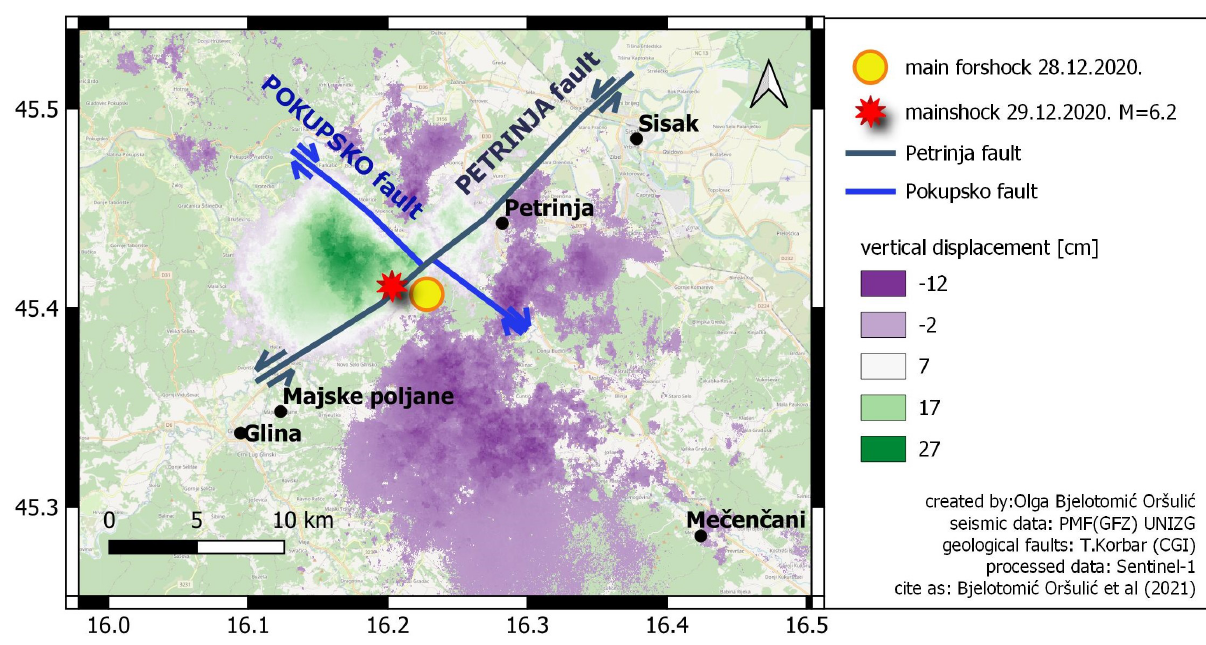
Figure 9. Figure shows vertical displacement over affected area. The results of analyzed GNSS data show that there has been a significant shift of SISA station of 5 cm towards the East and 2 cm to the South (see Figure 10). The eastern shift coincides with the results we obtained from the SAR analysis, while the north–south direction is not straightforward in SAR processing since SAR technique is more sensitive to horizontal east–west shift neglecting the north–south shift since the orbit path stretches along the north–south direction. As for the height, the SISA station shows subsidence up to 3 cm, as seen in Figure 11, which is the complementary result obtained by the SAR analysis: The identical displacement is obtained at the location of SISA station when vertical displacement is derived from SAR analysis, shown in Figure 9. Considering the geological field data acquired after the earthquake, a hundred sinkholes [76] opened as one of the extreme post-seismic near-surface effects [54] in a small place Meˇcenˇcani, located on a south-east line of Pokupsko strike-slip faults, as shown in Figure 9. Comparing the vertical displacements results obtained by SAR analysis and the geological occurrence of sinkholes, it is visible from Figure 9 that the impact on the vertical dimension was the strongest on the west side of Pokupsko strike-slip fault, reaching − 6 cm subsidence over the Meˇcenˇcani area, probably activating the occurrence of